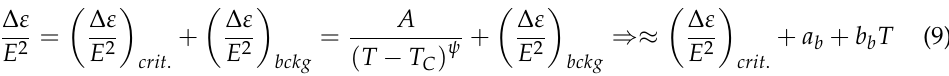
background term [82,105,106]. The problem was solved for critical mixtures composed of a dipolar component and a non-dipolar solvent [82,106,125–127]. Only the dipolar com- ponent introduces a meaningful contribution to the background effect for such